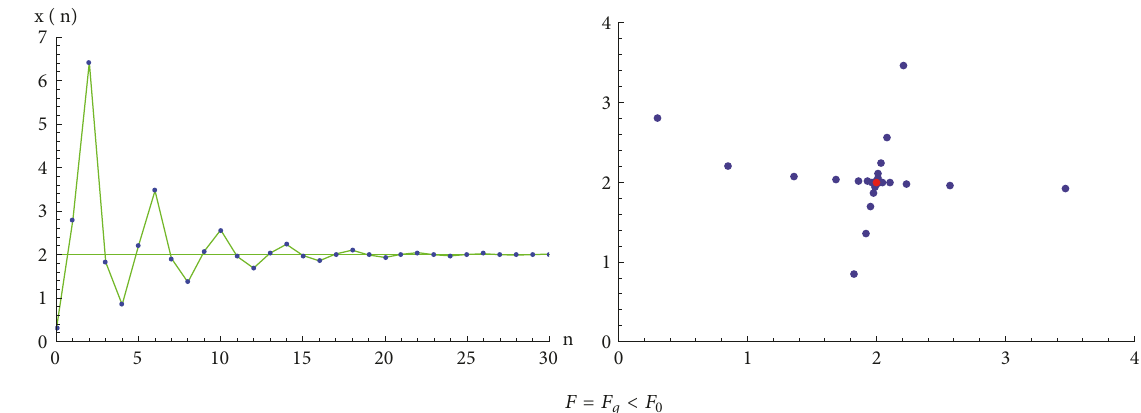
Figure 4: The orbit and the phase portrait for 𝑏 = 2 , 𝑐 = 1 , 𝐵 = 4 , 𝐹 = 8 , 𝐹 𝑔 = 8 , 𝐹 0 = 128 , and (𝑥 0 , 𝑥 −1 ) = (0.3,2.8) generated by Dynamica 4